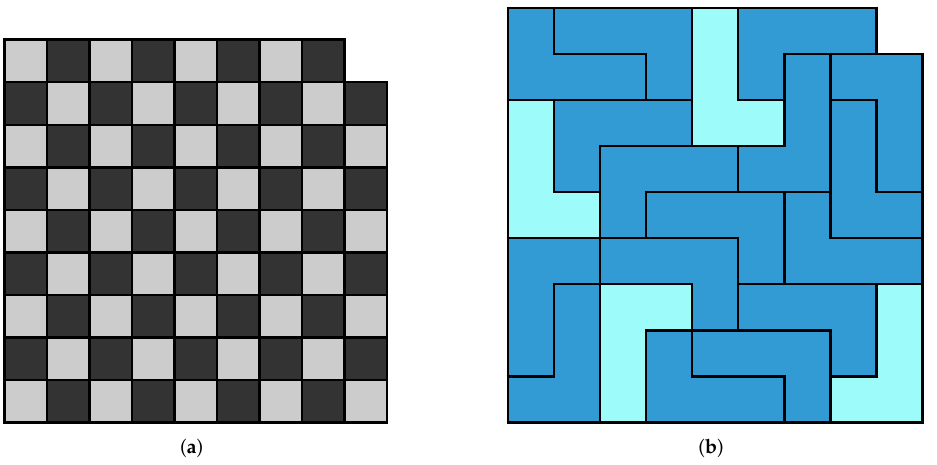
Figure 13. Target region and a tiling solution for Example 1: ( a ) The target region (cid:98) R , a checkerboard coloured 9-by-9 single-notched square; ( b ) Successful tiling of the target region (cid:98) R using 20 copies of an L-shaped tetromino. The P + variants are coloured light-blue and the P − 1 corresponding to an optimal solution of the subproblem with ( a +